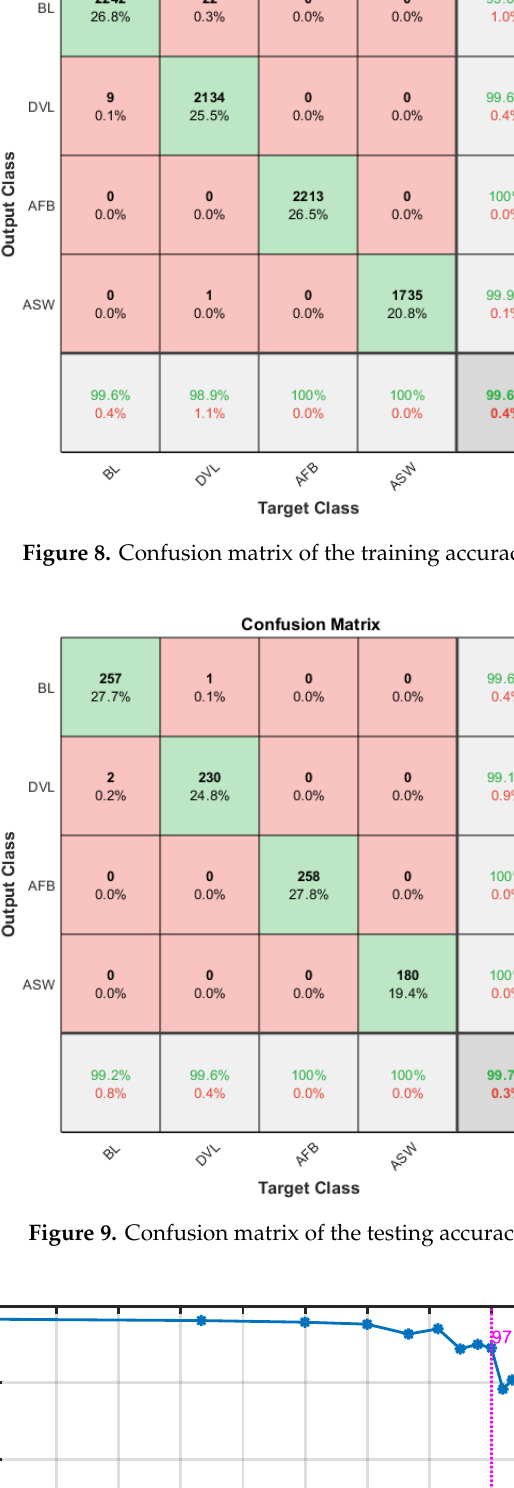
Figure 10. Effects of different proportions of training data on classification accuracy. One of the important merits using the proposed method for the thermal based monitoring is that it needs much less computational effort, compared with the deep learning-based methods [31]. Moreover, this thermal image analysis-based monitoring approach can have more comprehensive monitoring information at a lower cost of instrumentation and processing effort, compared with vibration [3,4,7], acoustics [4,5] and motor current based [8] monitoring methods. Furthermore, the developed supervised learning model in the laboratory environment can be transferred easily into